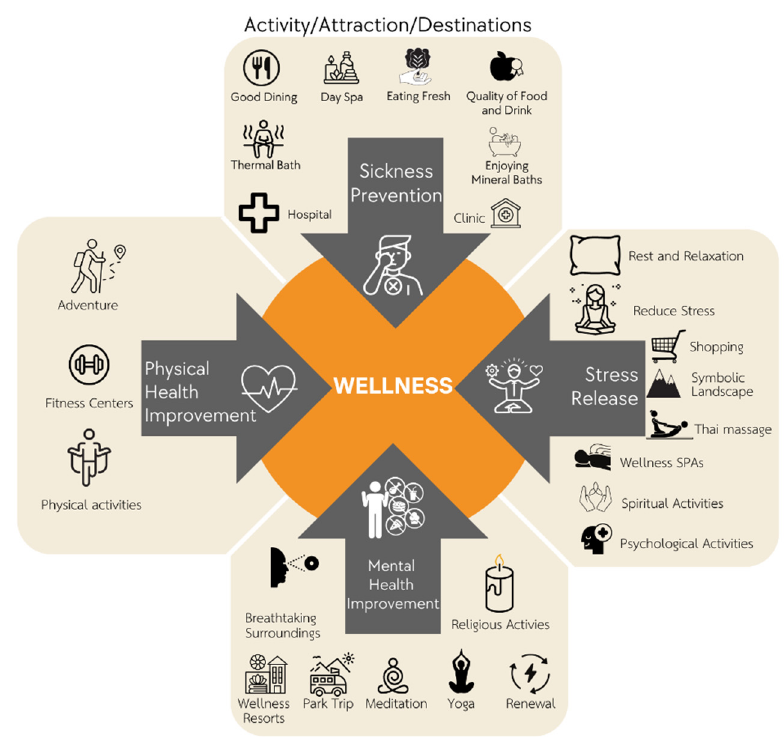
Figure 3. Wellness connection of aims of travelling and activities of wellness tourism.